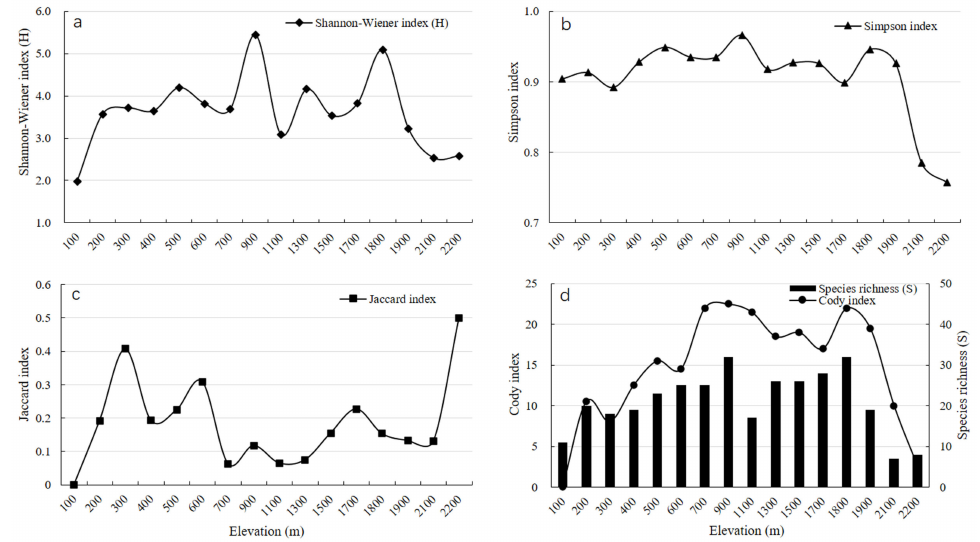
Figure 2. Indices of plant diversity along the altitudinal gradient in the central Taihang Mountain region, northern